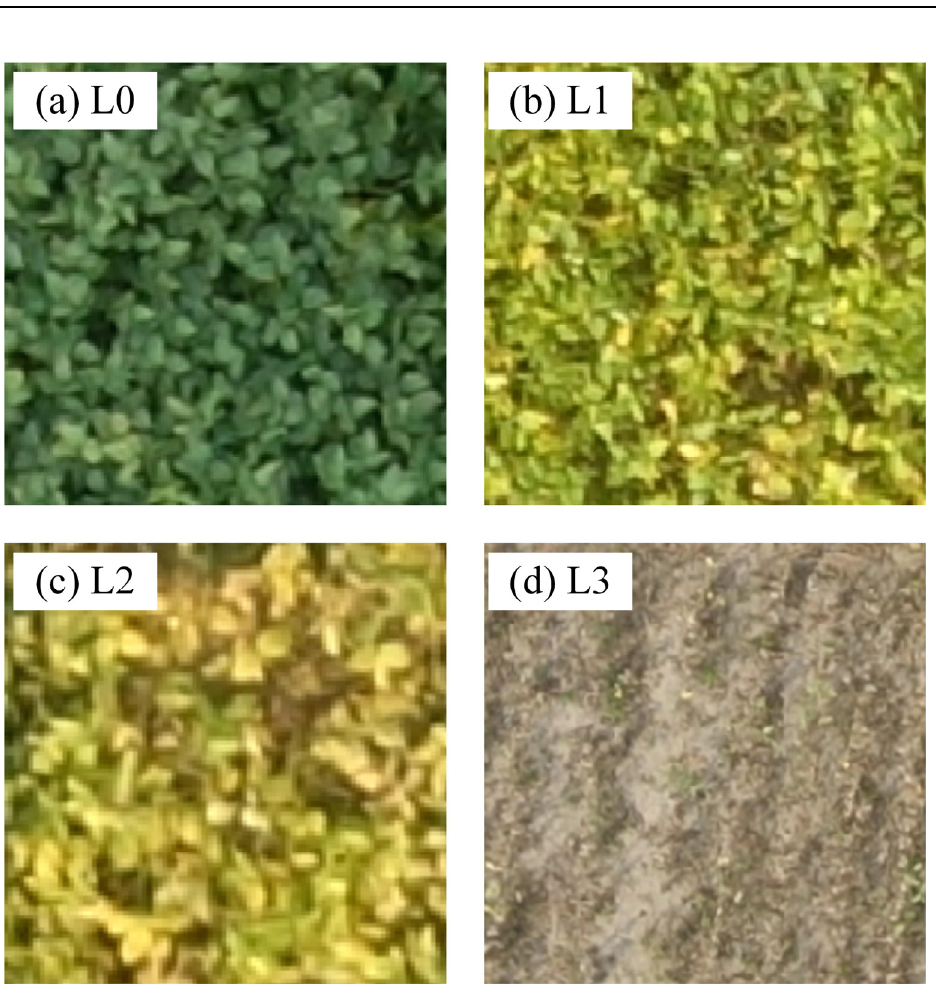
Figure 2. Examples of the four labels. Table 3. Numbers of soybean images for model calibration and validation.